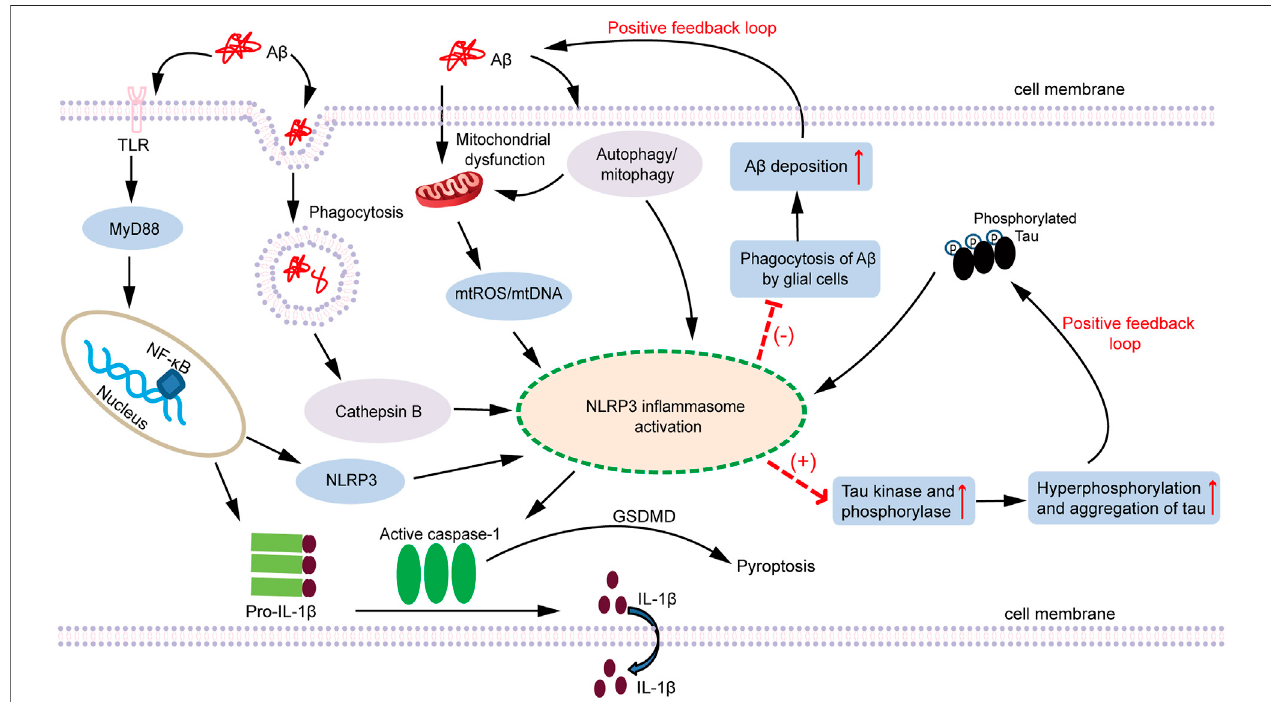
FIGURE 1 | A schematic diagram of the association between NLRP3 in fl ammasome activation and AD pathogenesis. Both A β oligomers and Tau aggregates are involved in the in fl ammatory response of AD. Fibrillar A β species are regarded as PAMPs that triggers NF- κ B activation through pattern recognition receptors (such as TLRs) to elevate in fl ammasome components NLRP3 and pro-IL-1 β . NLRP3, ASC, and pro-caspase-1 assemble together to form the NLRP3 in fl ammasome, which subsequently activates caspase-1, cleaves pro-IL-1 β to produce theactive form ofIL-1 β and secretes itextracellularly. Inaddition, phagocytosis of solubleA β also triggers lysosome leakage and consequently results in the emission ofcathepsin B, which leads to NLRP3 in fl ammasome activation. Furthermore, A β oligomerscan act as damaging stimulis to induce mitochondrial dysfunction, causing the production and accumulation of ROS, release of mtDNA, or cardiolipin externalization, which activates the NLRP3 in fl ammasome. Autophagy can not only clear A β , but also clear NLRP3, ASC and pro-caspase-1 in fl ammasome-related protein molecules. Mitophagy can selectively remove impaired mitochondria and relieve the release of damaging molecules within mitochondria. Therefore, autophagy and mitophagy can negatively regulate the activation of NLRP3. A β also indirectly regulate the activation of the NLRP3 in fl ammasome through the autophagy or mitophagy pathway. Moreover,theactivationofNLRP3in fl ammasomeinhibitsthephagocytosisofA β byglialcells,whichcontributestothedepositionofA β andfacilitatestheformationofA β plaques.Inconclusion,A β canactivatetheNLRP3in fl ammasomethroughdifferentpathways. However,oncetheNLRP3in fl ammasomeisactivated, itinturnincreases thedepositionofA β andtheformationofA β plaque,whichformsapositivefeedbackloopthatampli fi esA β pathogeniceffect.SimilartotheroleofA β ,Tauisregardedas an endogenousdangerousmolecule that canactivate the NLRP3 in fl ammasome. Afterthe NLRP3 in fl ammasome isactivated,itincreases the activity of Taukinase and phosphorylase, and facilitates the phosphorylation and aggregation of Tau, thereby also forming a positive feedback loop. Persistent activation of the NLRP3 in fl ammasome triggered by A β and Tau contributes to the development of chronic neuroin fl ammation, which ultimately leads to the neuronal loss and cognitive impairment.AD:Alzheimer ’ sdisease;A β :amyoid β ;PAMPs:pathogen-associatedmolecularpatterns;TLRs:Toll-likereceptors;NF- κ B:nuclearfactorkappaB;NLRP3: nucleotide-binding oligomerization domain-like receptor pyrin domain-containing 3; ASC: apoptosis-associated speck-like protein containing a CARD; ROS: reactive oxygen species; mtROS: mitochondrial ROS; mtDNA: mitochondrial DNA; MyD88: myeloid differentiation factor 88; GSDMD: gasdermin D.